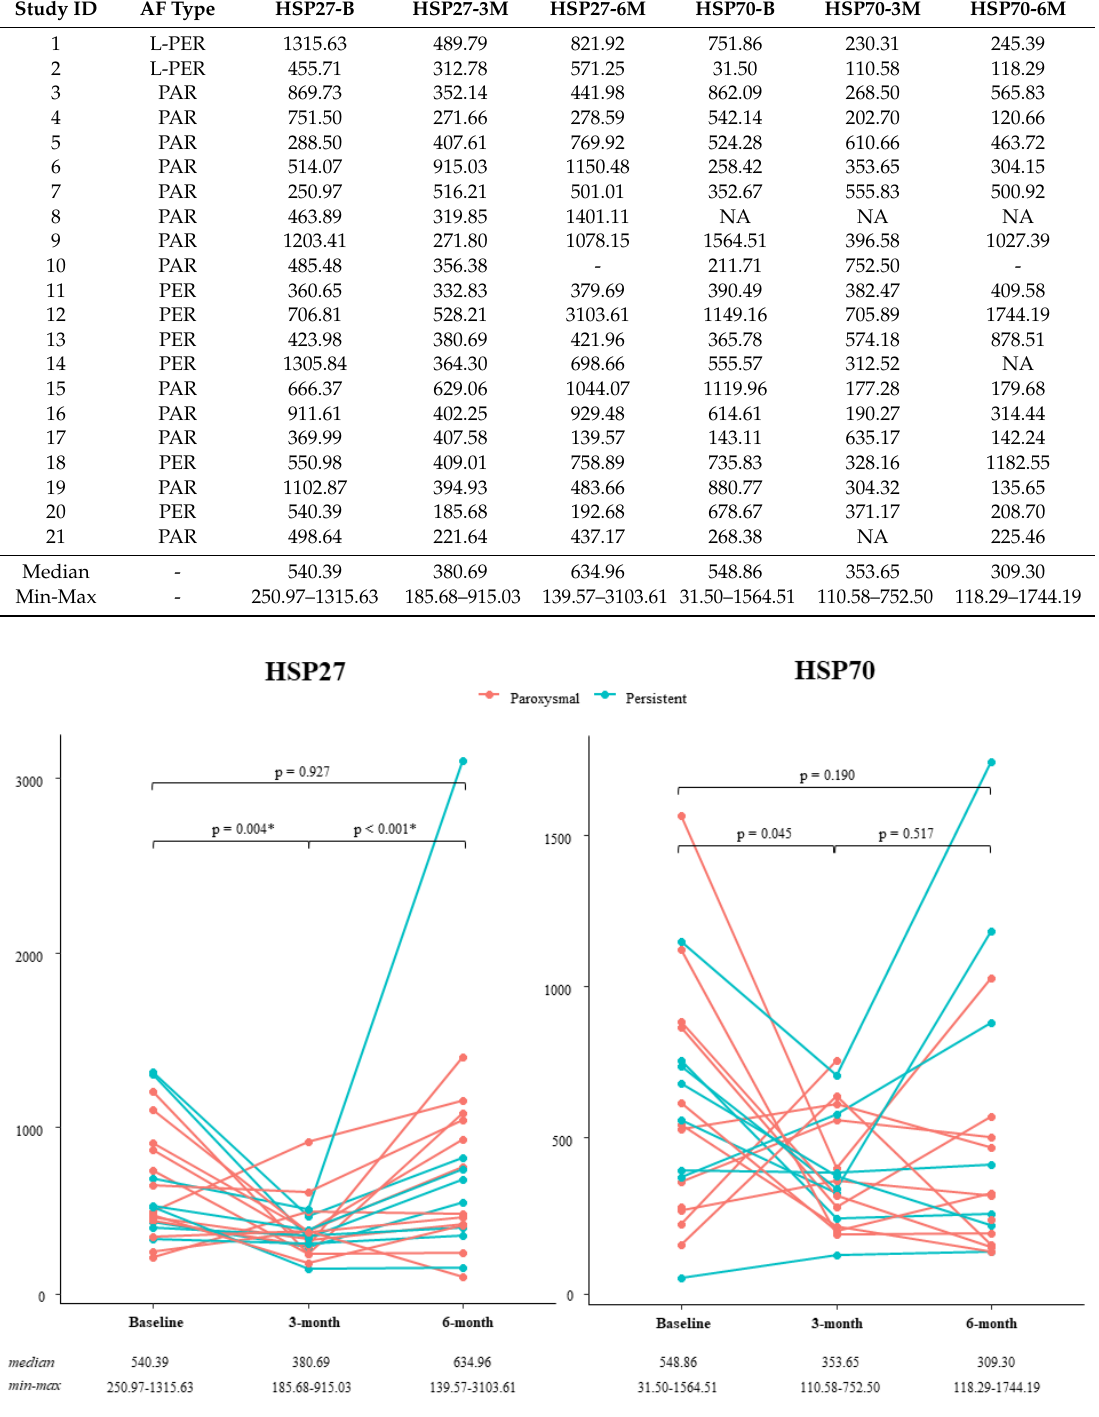
Table 2. Serum levels of HSP27 and HSP70 at baseline (B), 3-month (3M) and 6-month (6M) follow-up. L-PER = longstanding persistent AF, NA = not available, PAR = paroxysmal AF, PER = persistent AF.